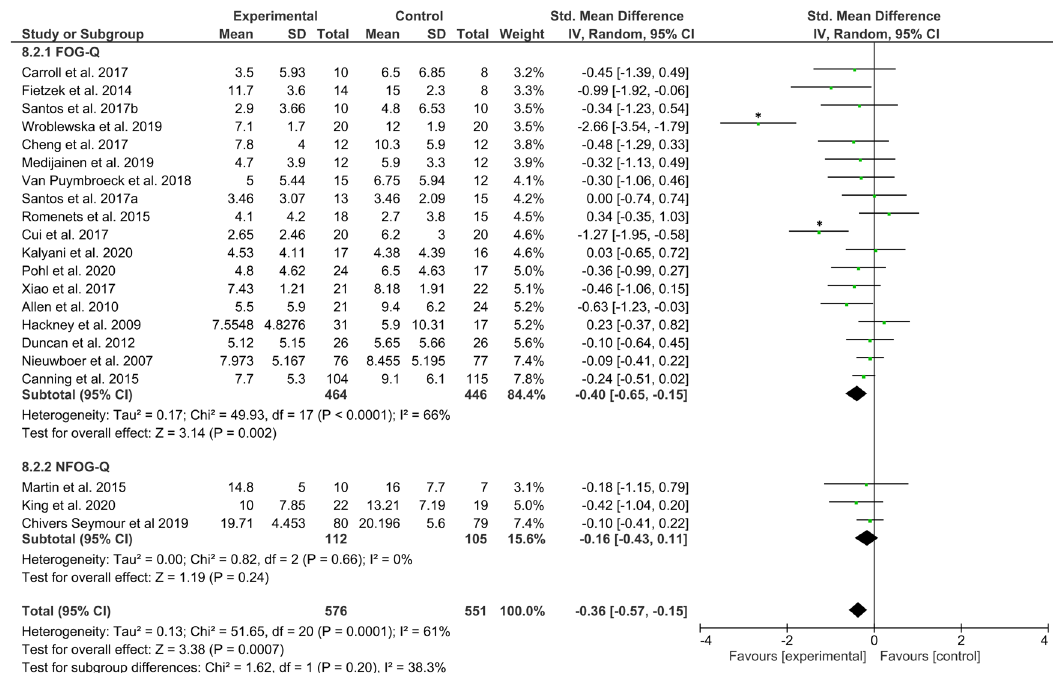
Fig. 4 Secondary analysis comparing the effect of all types of training/exercise interventions against passive control groups. The studies are arranged per weight of the study as based on sample size; *signi fi cant outliers removed in the sensitivity analysis.